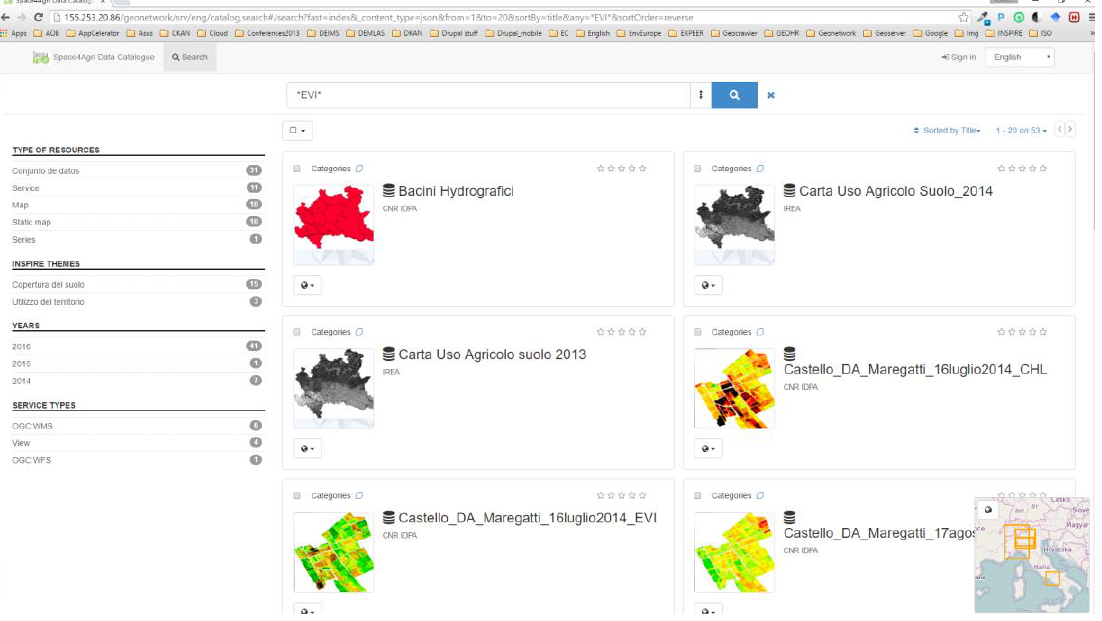
Figure 9. Discovering the GD layers available for the theme NDVI_MODIS and INSPIRE metadata of a series NDVI MODIS for year 2013 (Source: own processing).